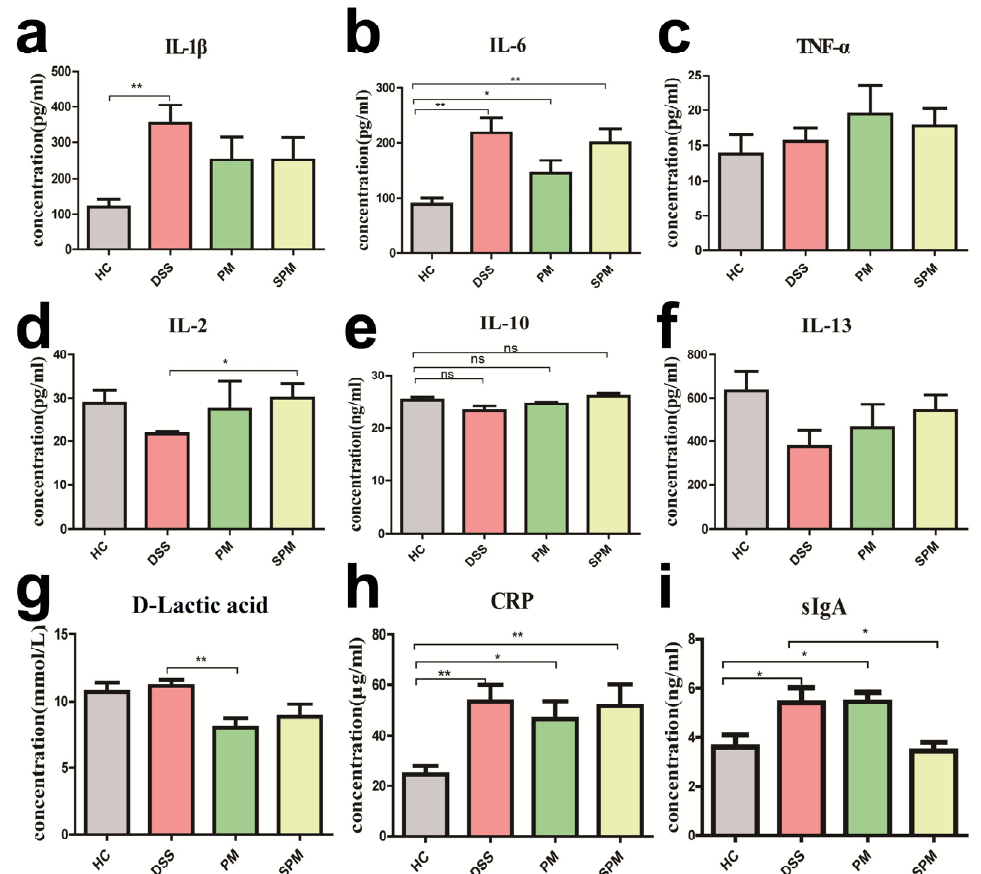
Figure 3. Expression of cytokines of colon tissues or serum in mice. ( a ) IL-1 β ; ( b ) IL-6; ( c ) TNF- α ; ( d ) IL-2; ( e ) IL-10; ( f ) IL-13; ( g ) D-lactic acid; ( h ) CRP; ( i ) sIgA. The levels of IL-1 β , IL-6, TNF- α , IL-2, IL-10, IL-13 and sIgA were measured in colon tissues. The levels of D-lactic acid and CRP were evaluated in serum. * p < 0.05, ** p < 0.01, ns: no significant difference.